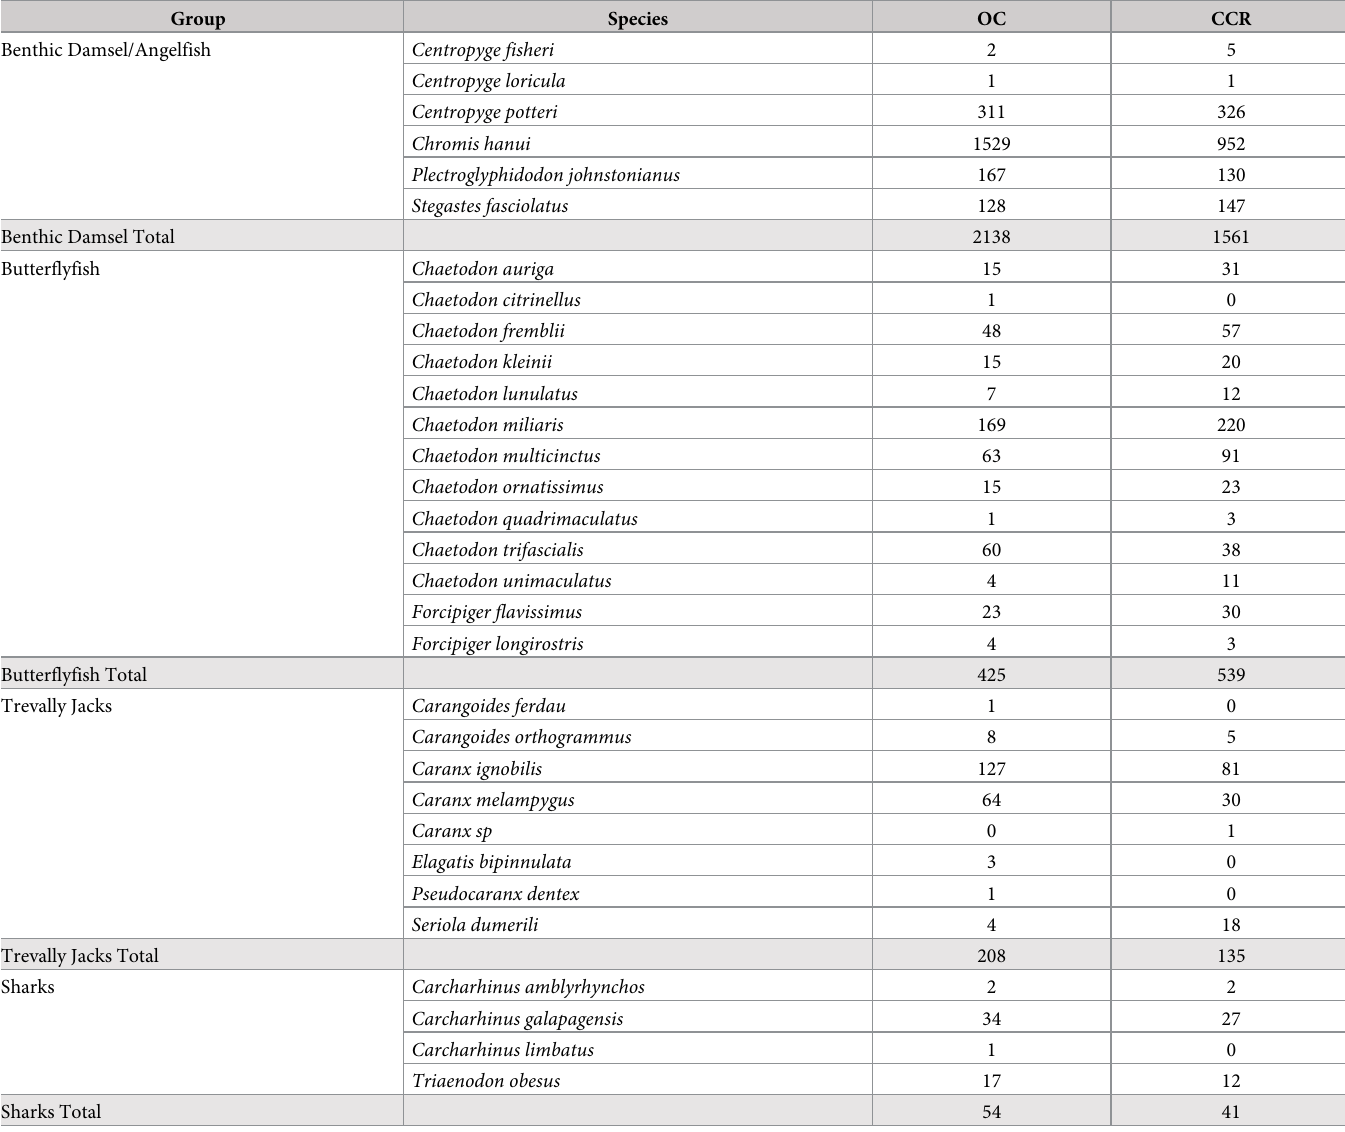
Table 1. Fish counts of individuals per group at the species level. All of these groups except the sharks showed significant differences between gear types. The groups of benthic damselfish/angelfish, butterflyfish, jacks, and sharks are listed with total number of fish counted for the 35 surveys conducted on each gear type.